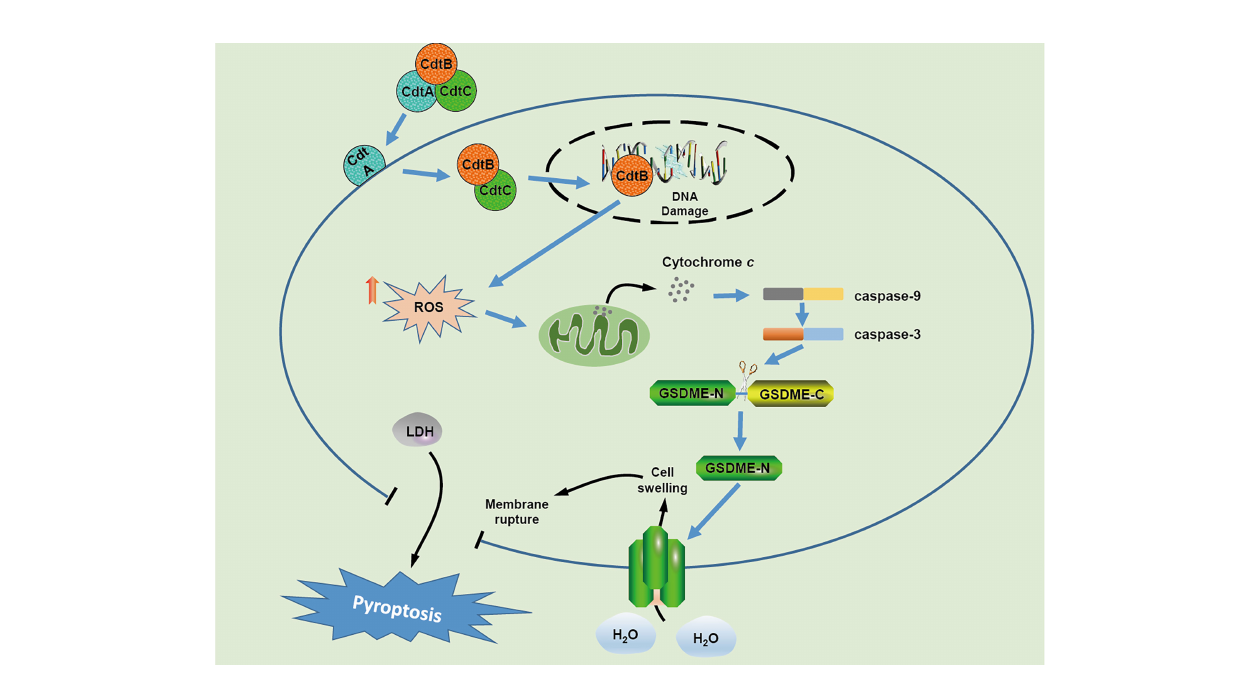
FIGURE 6 | Schematic model of cellular mechanism underlying CDT induced pyroptosis in human colonic epithelial cells.In CDT treated-target cells, CdtB is relocated to the nucleus through the assistance of CdtA and CdtC, which results in DNA double strand breaks owing to its DNase activity. Upon DSB formation, the production of cellular ROS is increased and subsequently triggers the release of cytochrome c, followed by the activation of caspase-9 and caspase-3 The activated caspase-3 further cleaves GSDME, and eventually induces cell swelling and membrane